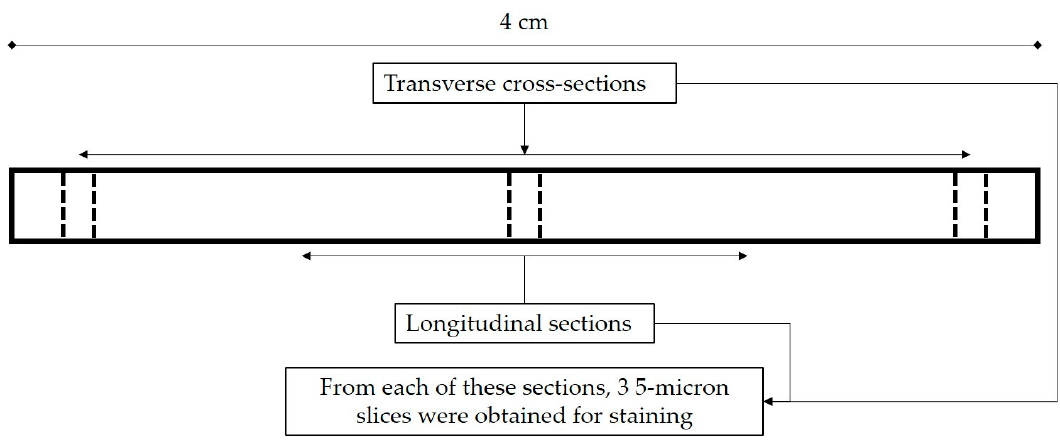
Figure 8. Sample preparation for histology. The bold frame represents a 4-cm tendon segment and dash lines indicate where cuts were made with a scalpel to 3 transverse and 2 longitudinal sections.